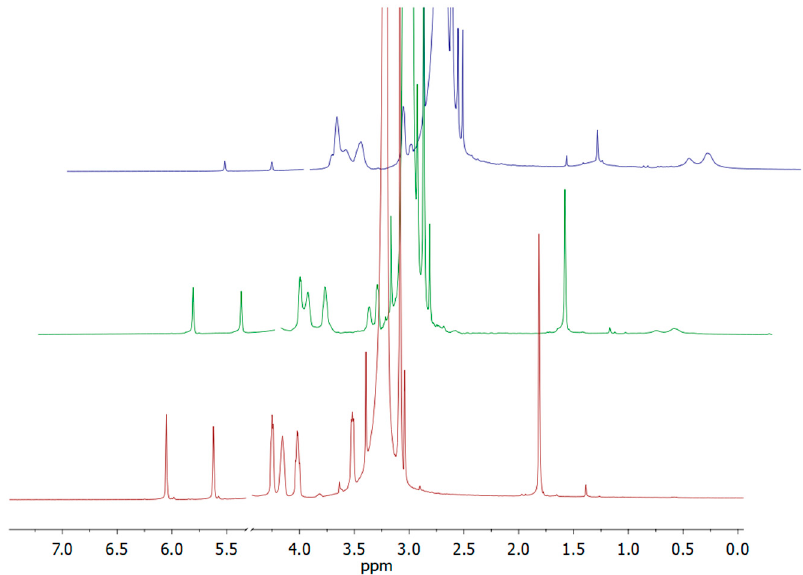
Figure 4. 1 H NMR spectra recorded at different reaction times ( t = 0, 4 and 24 h from bottom to top) during the synthesis of copolymer p(MPC- co -PTMSi1).